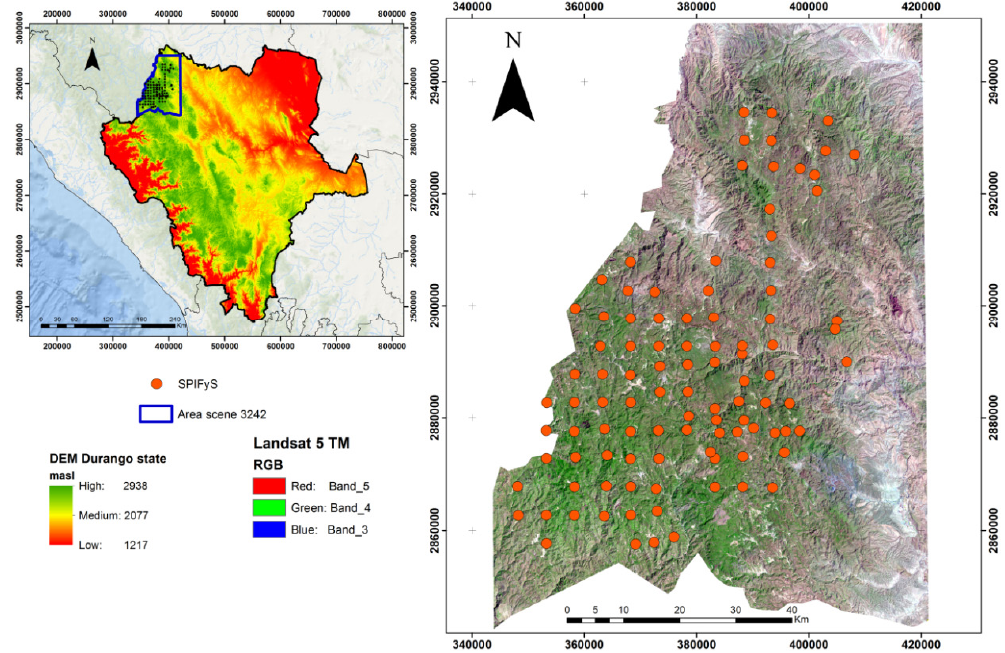
Figure 1. Location of the study area and of the permanent forest growth and soil research sites (SPIFyS).